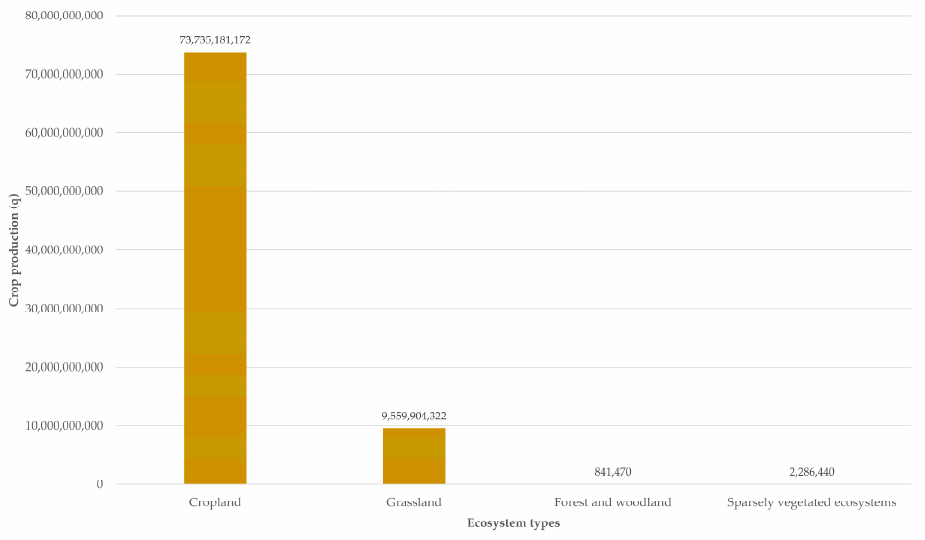
Figure 9. Crop production with respect to the types of ecosystems (2018).